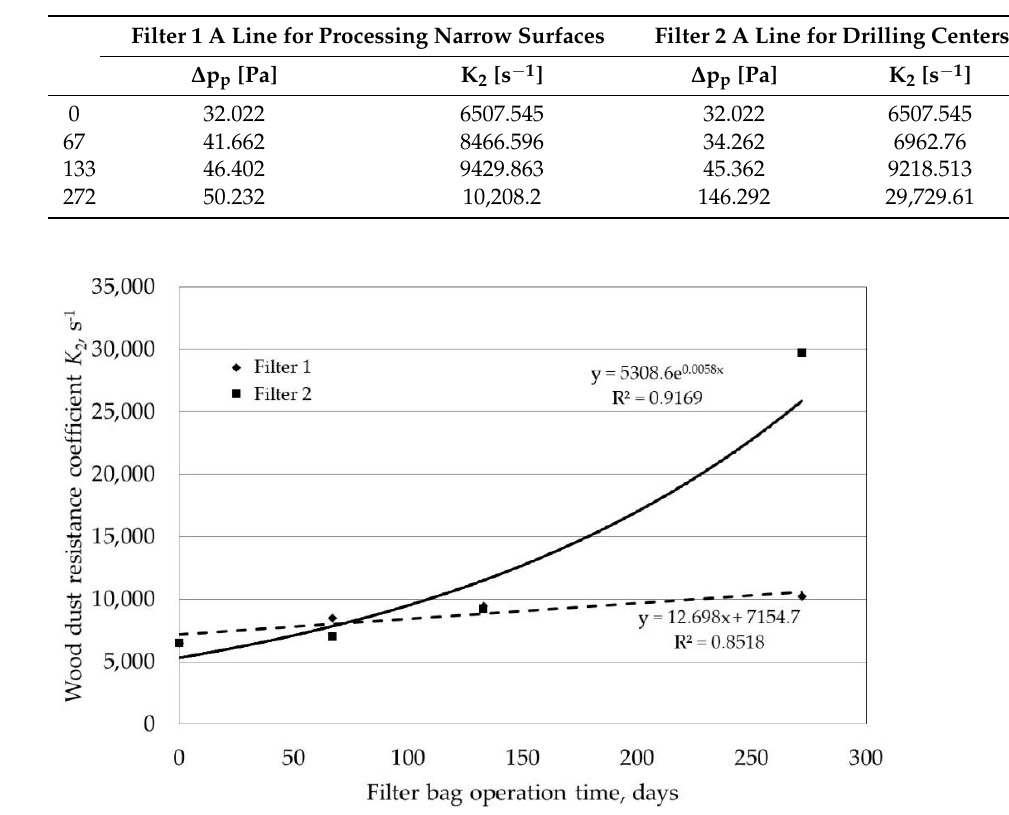
Figure 9. The value of the K 2 coefficient depending on the working time of the bags. Table 7. Working conditions of bags in industrial installations and results of the dust resistance coefficient K 2